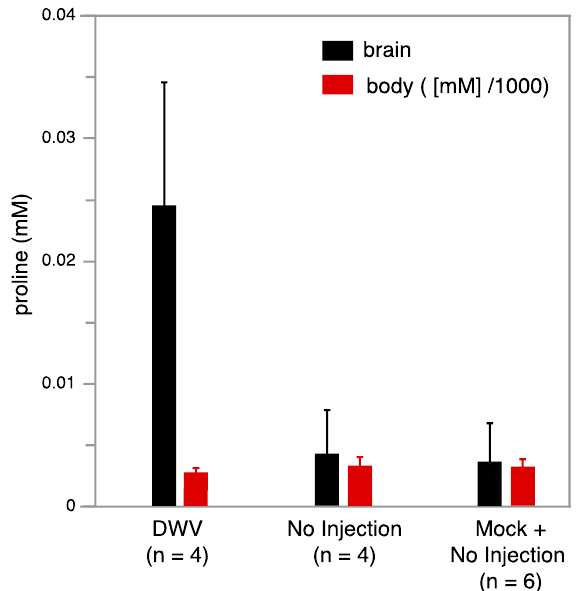
Figure 5. Average proline concentration in 0.5 mL NMR buffer as a function of DWV state for bee brains (left hand black bars) and corresponding bodies (right hand red bars) is illustrated. Proline increases strongly in the brains of DWV infected workers, but is relatively unchanged in corresponding bodies. The proline concentration in 0.5 mL NMR buffer extracted from the corresponding bodies was much higher and its value was scaled down by 1000 (e.g., for the bodies the scale corresponds to M).